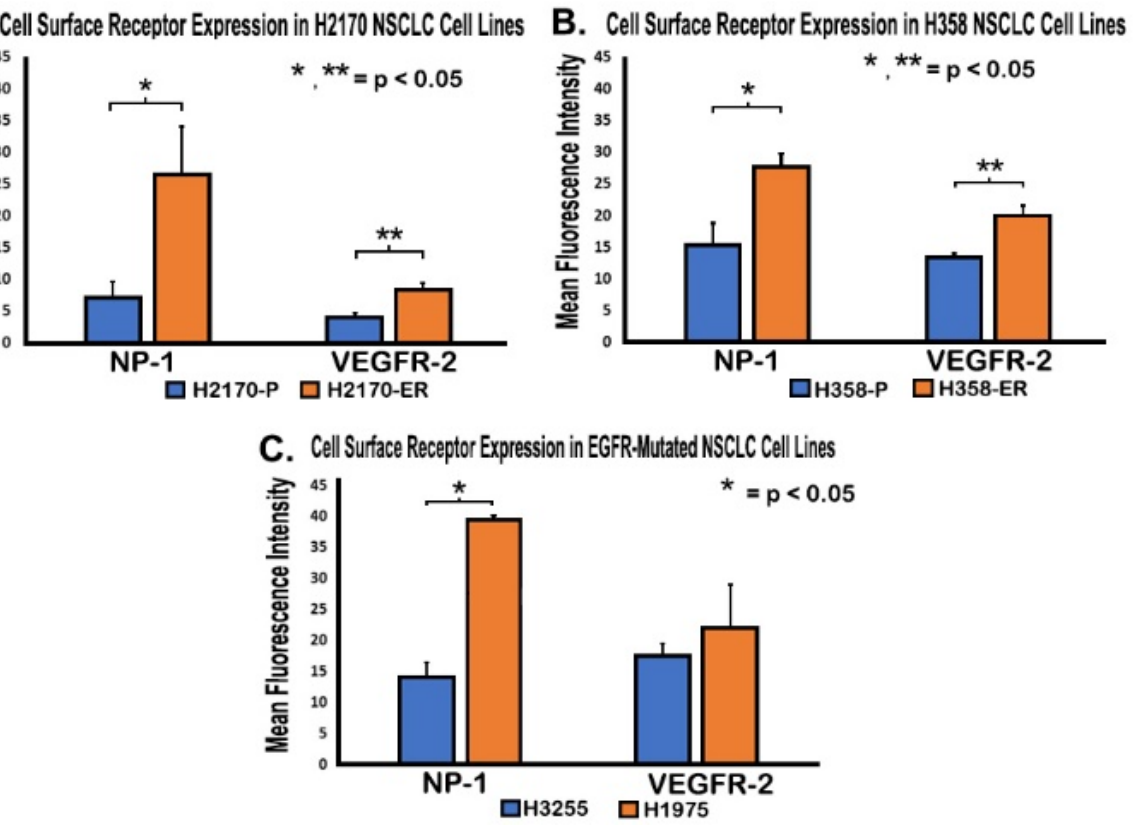
Figure 3. Increased cell surface expression of VEGFR-2 and NP-1 receptors in Erlotinib-resistant NSCLC cell lines. For the analysis, 5 × 10 5 H2170-P/ER, H358-P/ER, H1975, and H3255 cells were seeded in a Petri dish and allowed to grow and adhere for 48 h. After the growth medium was removed, the cells were washed and detached. Cells were then collected, pelleted, re-suspended in a buffer, pelleted again, probed with antibody, washed, and re-suspended in buffer before being used for flow cytometry. Cell surface expression was compared in ( A ) H2170-ER cells compared to H2170-P cells, (B ) H358-ER cells compared to parental cells, and ( C ) T790M- and L858R-mutant H1975 cells compared to L858R-mutant H3255 cells. Statistical analyses were performed, and it was demonstrated that the results were statistically significant ( p < 0.05) by m of two-tailed t -test analyses. One asterisk (*) denotes the statistical significance of data concerning NP-1, whereas two asterisks (**) denote the statistical significance of data concerning VEGFR-2.